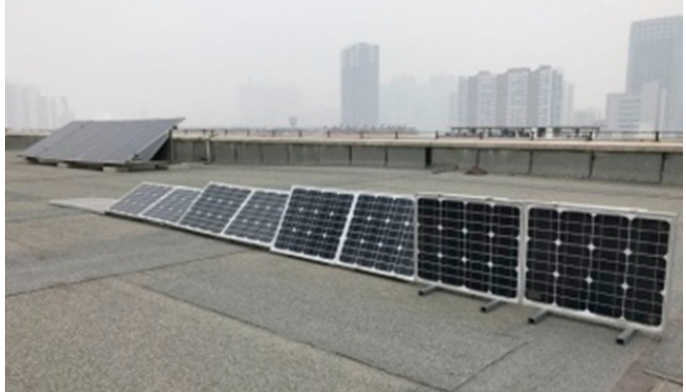
Figure 8. Arrangement of the PV panels.